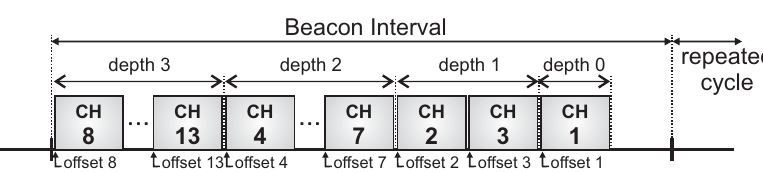
Figure 4. Bottom-up cluster active period